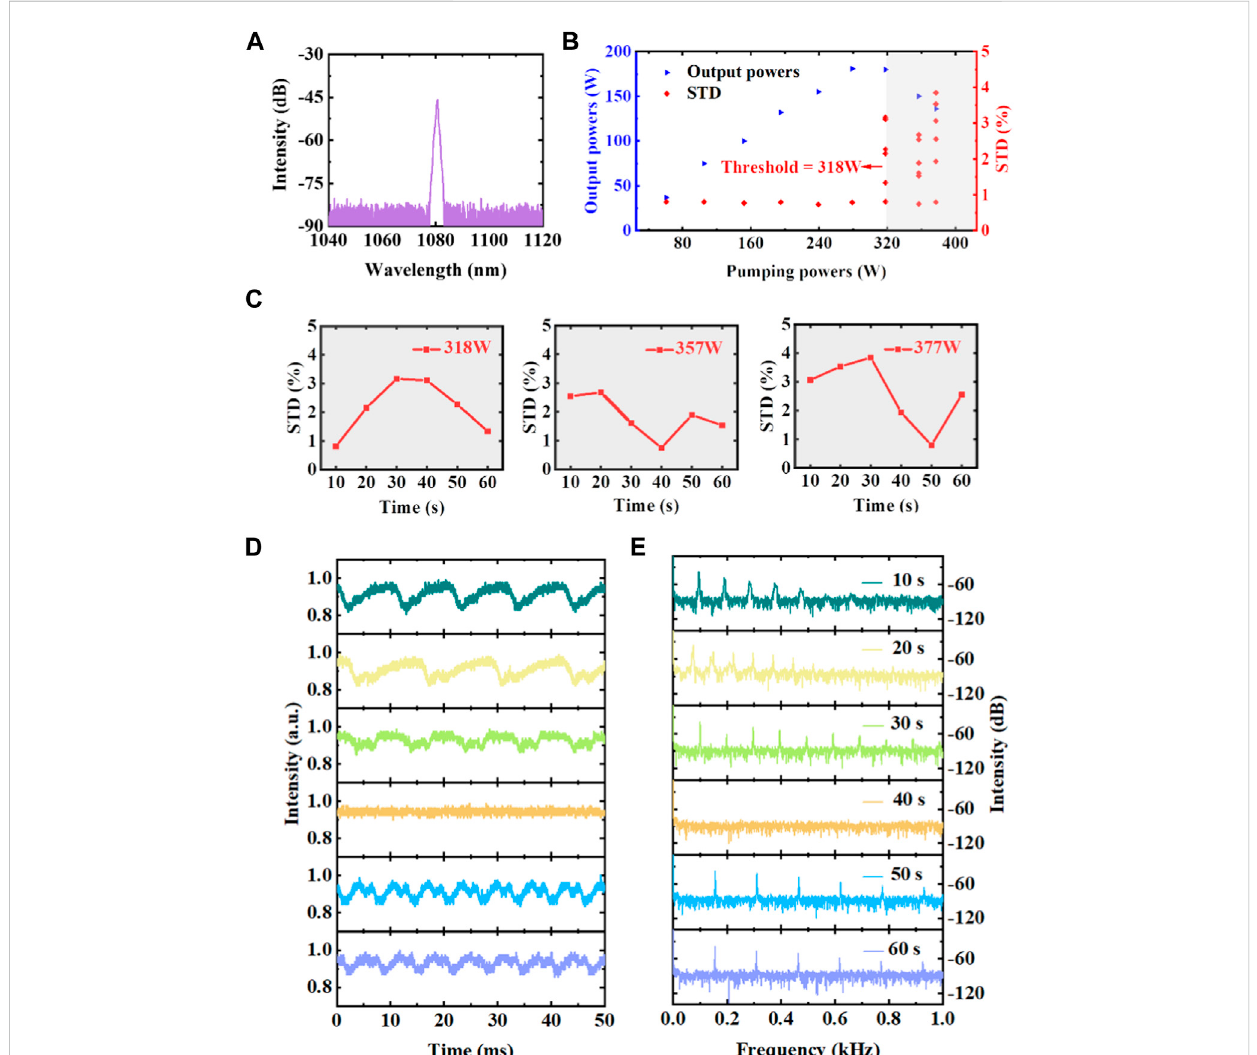
FIGURE 2 Thespectrumandevolutionoftheoutputpowerandstabilityofthebeamemittedbytheco-pumping fi berlaseroscillator: (A) Theoutputspectrum at the output power of 155 W. (B) The output power and STD of the temporal signal at distinct pumping power. (C) Six recordings within 60 s of the time domain STDs at three pumping powers of 318, 357, and 377 W (The data is collected every 10 s). (D) Six temporal traces with fi rst 50 ms in every 10 s in sequence at the pumping power of 357 W. (E) Fourier spectra of intensity